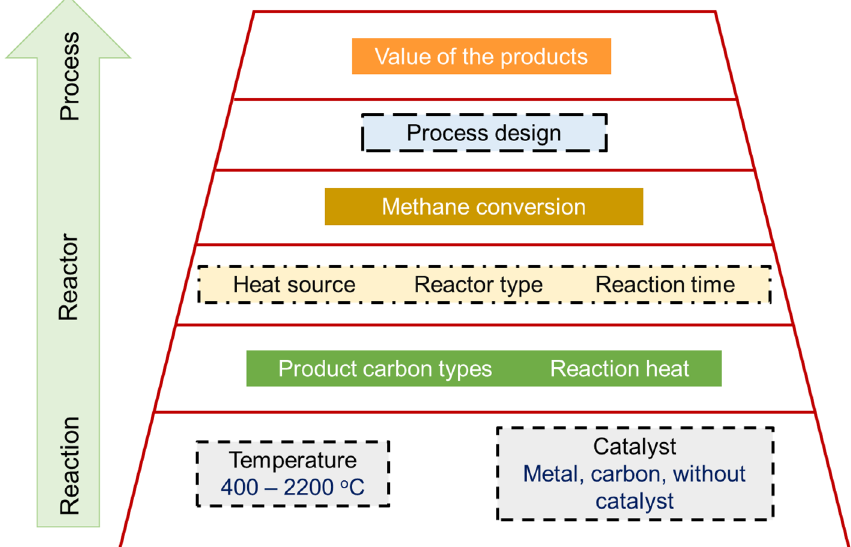
Fig. 1 Catalytic decomposi- tion pathway in constructing the reaction parameter adopted from Keipi et al.